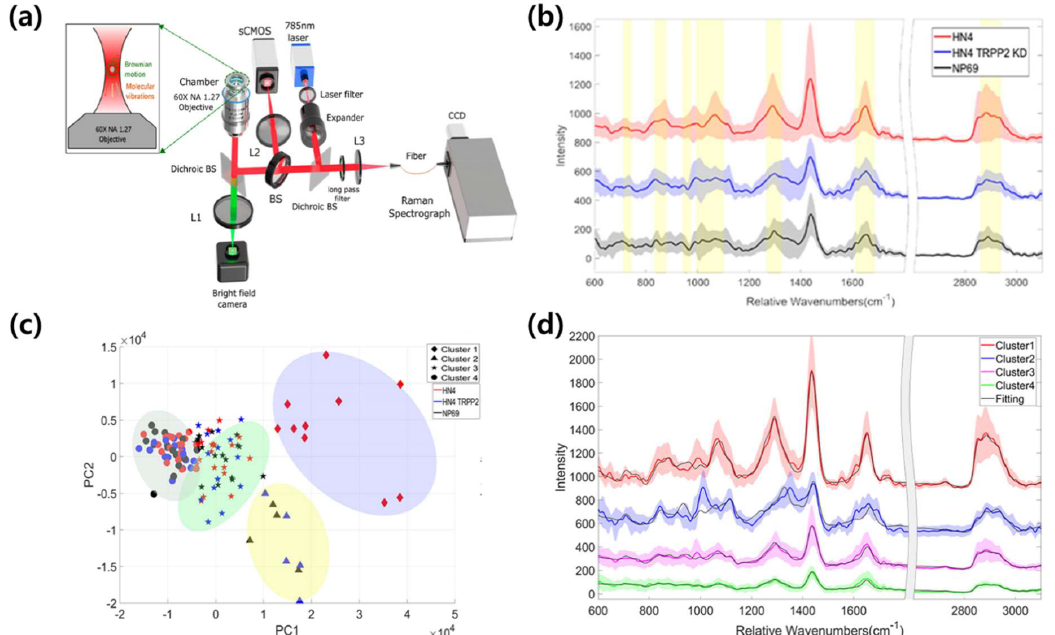
Figure 7. Optical tweezer-based single EV Raman detection system and the Raman signal and PCA results obtained using it. ( a ) Overview of Raman-enabled nanoparticle trapping analysis (R-NTA)